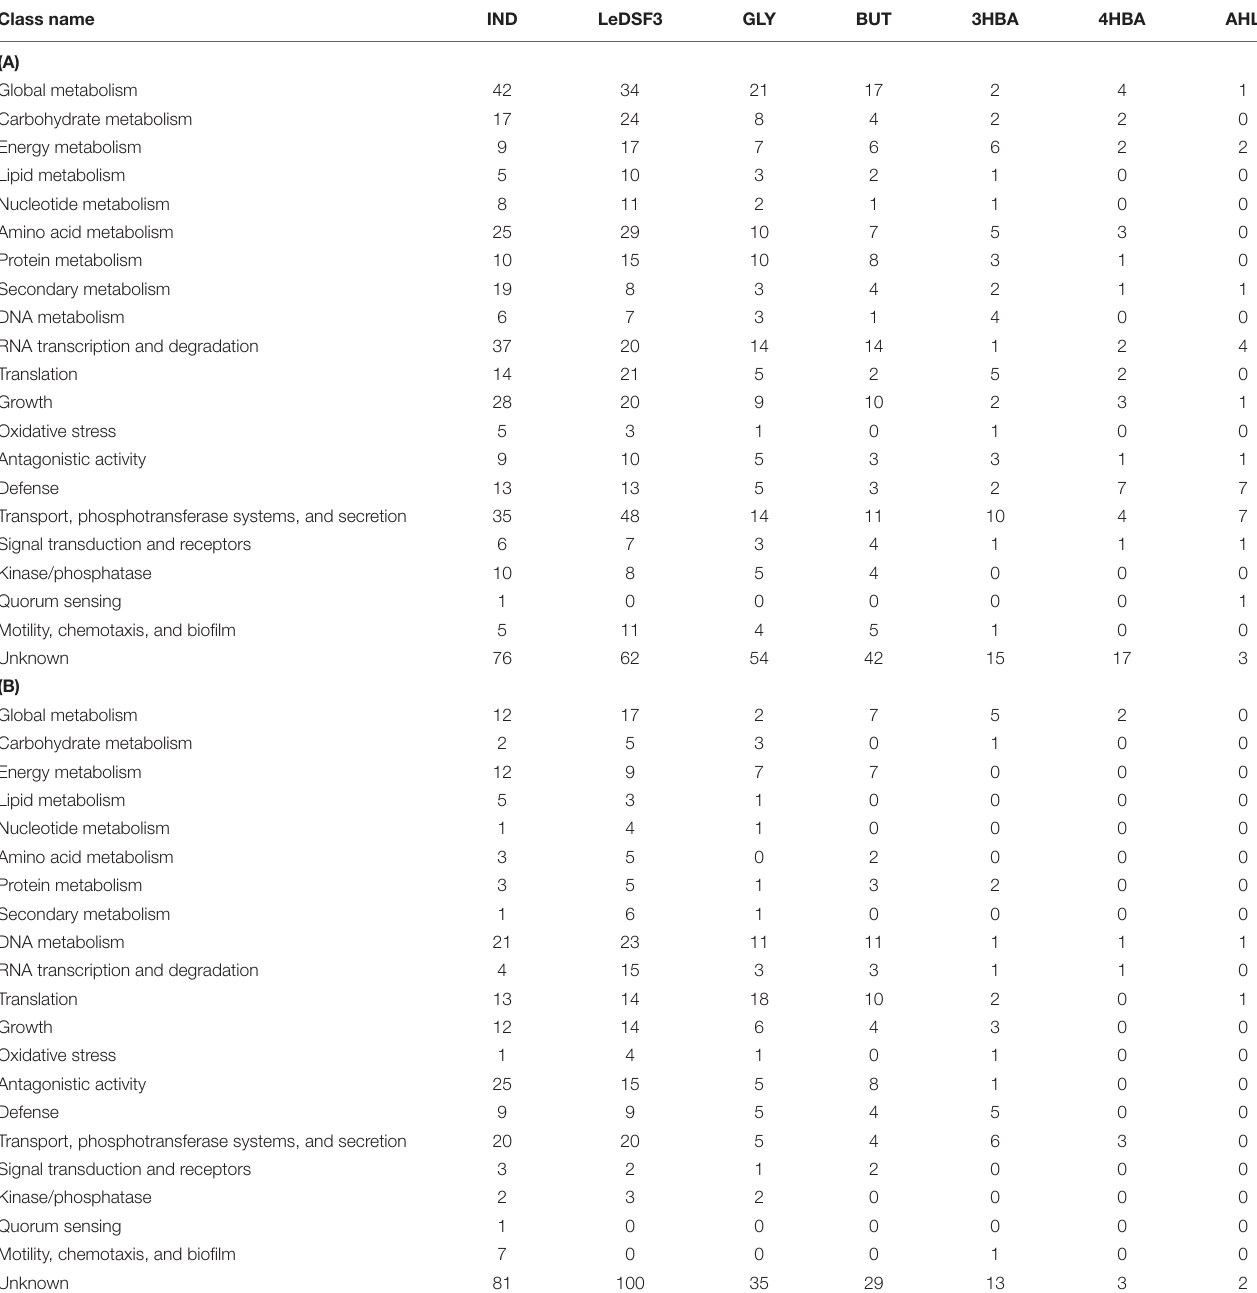
TABLE 3 | Number of (A) upregulated and (B) downregulated differentially expressed genes in Lysobacter capsici AZ78 in response to diffusible communication